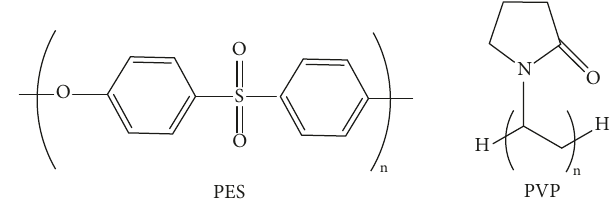
Figure 2: Chemical structure of PES and